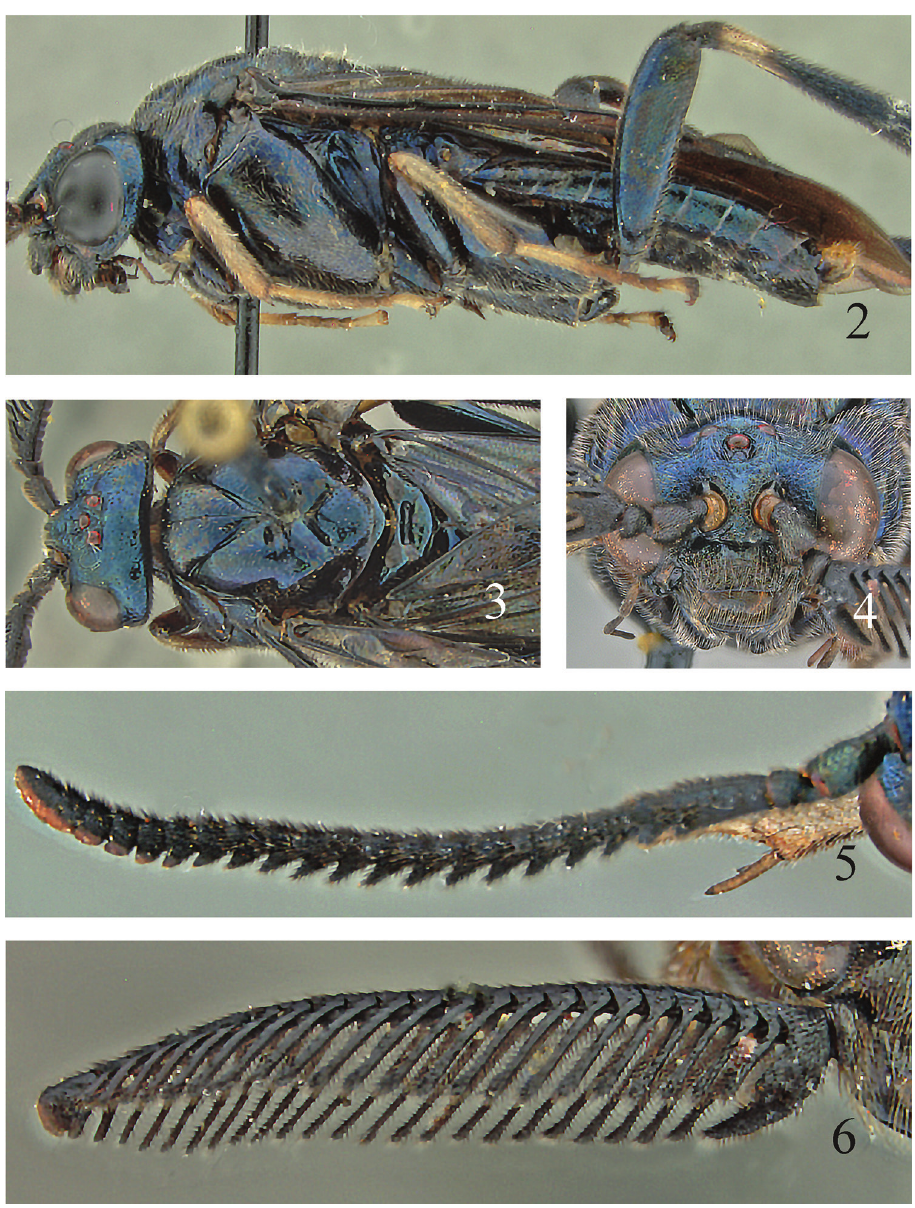
Figures 2–6. Cladiucha insolita . 2 Male, lateral 3 Male, dorsum of head and thorax 4 Male, head front 5 Female antenna 6 Male